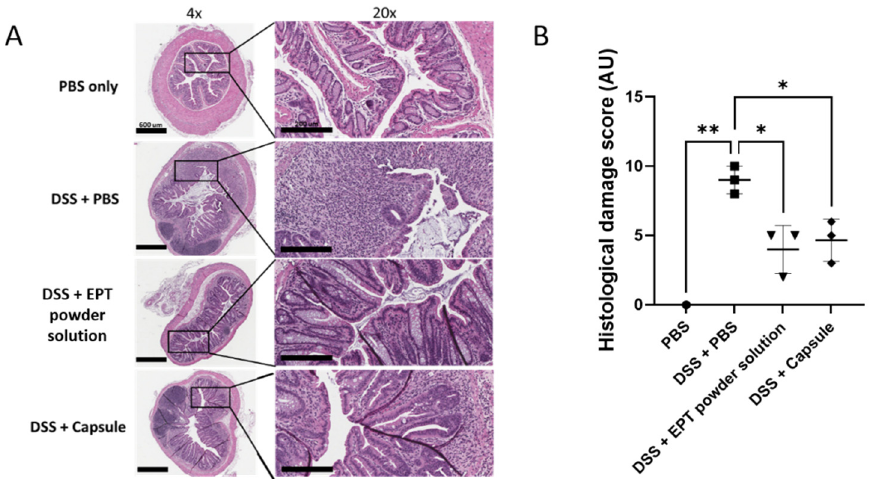
Figure 4. Treatment with encapsulated EPT mitigates acute colitis in mice. Encapsulated EPT (DSS + Capsule) treatment protected mice from histological damage similarly to treatment with EPT powder solution following gastric acid neutralization (DSS + EPT powder solution). ( A ) Representative 4x (left) and 20x (right) photomicrographs of H&E-stained distal colon tissues from each treatment group. ( B ) Histological damage scores of each treatment group in the DSS acute colitis study. * p < 0.05, ** p < 0.01; one-way repeated measures ANOVA with Bonferroni’s multiple comparisons test .